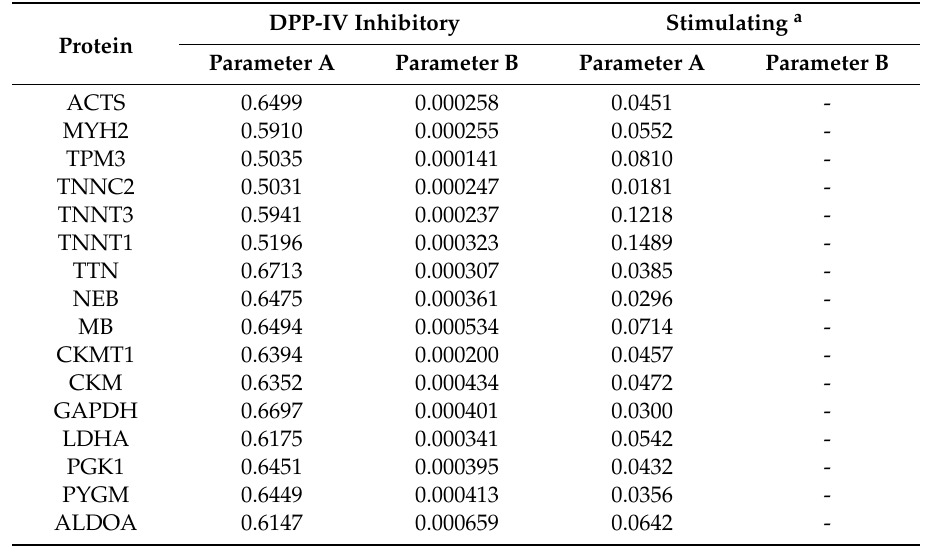
Table 2. Results of the potency evaluation of the intact porcine proteins as sources of bioactive peptides.